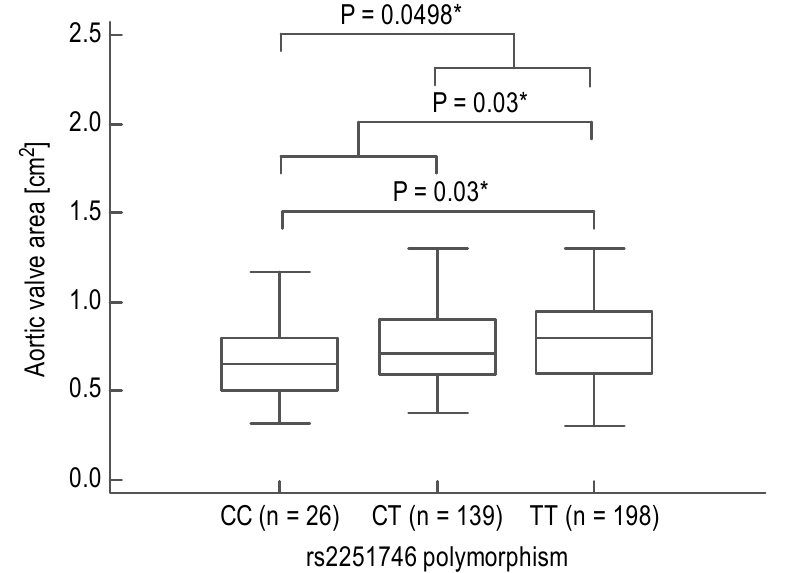
Figure 2. Median aortic valve area in acquired aortic stenosis patients having different genotypes of the high-affinity immunoglobulin E receptor α -subunit locus ( FCER1A ) rs2251746 polymorphism. Boxes range from the 25th to the 75th percentile with a horizontal line at the median and vertical lines extending to the 10th and 90th percentiles. P -values calculated using Mann–Whitney test are given. P -values of less than 0.05 are marked with a star (“*”).